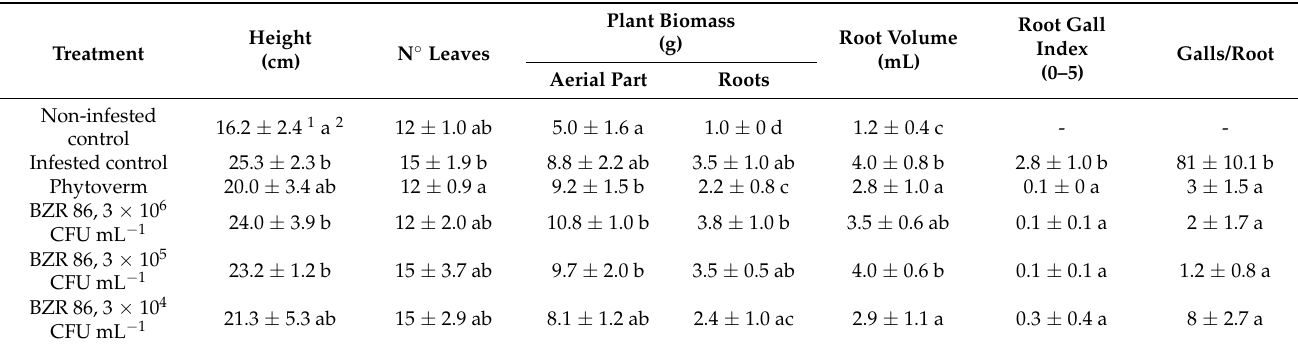
Table 4. The influence of Bacillus velezensis BZR86 on the growth and infestation of Meloidogyne incognita on tomato (cv. Balkonnoe chudo).